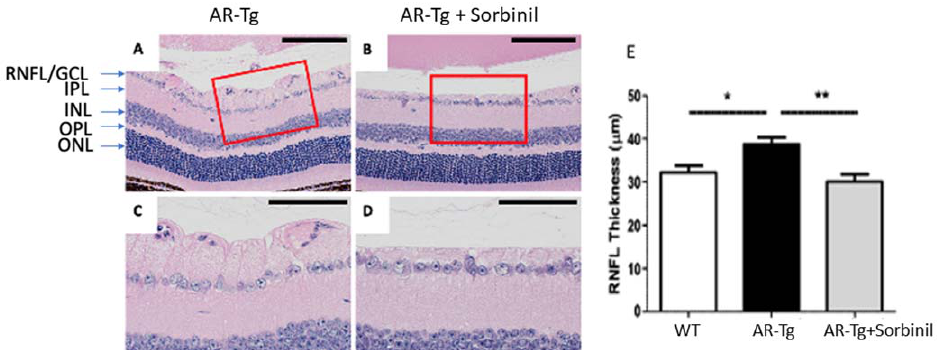
Figure 2. Sorbinil inhibition of retinal thickening in AR-Tg mice. Histological comparison of RNFL complex thickness of untreated AR-Tg controls ( A ) and Sorbinil-treated AR-Tg mice ( B ). Scale bar = 100 µ m. Areas outlined in red are shown in expanded view in ( C , D ), where scale bar = 50 µ m. Measurements of RNFL complex thickness ( E ) were carried out at 18 weeks of age, including ≥ 4 mice/observation group. H&E-stained histological sections shown are representative of six eyes. * p < 0.05; ** p < 0.01. Labeling of retinal layers is as in Figure 1.